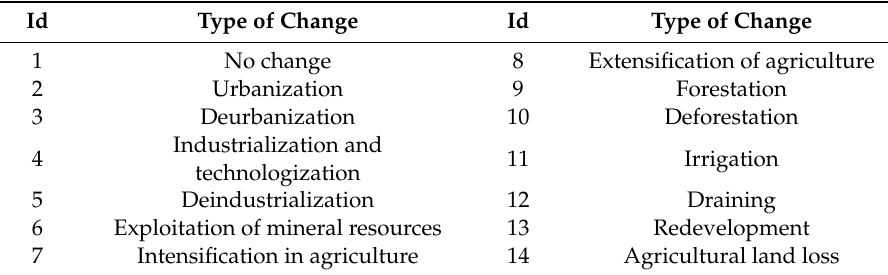
Table 1. The processes considered in landscape change evaluation.